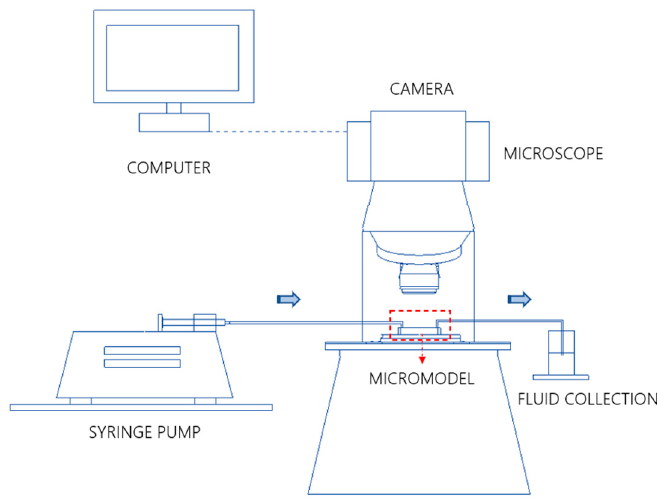
Figure 10. Experimental setup.